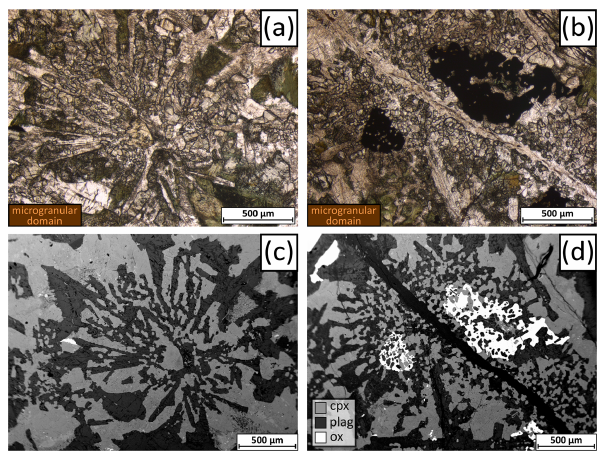
Figure 7. Rosette-like, microgranular domains within two varitex- tured gabbros ( a, c : GT3A-129Z-3, 50–57cm; b, d : GT3A-129Z-4, 8–16cm) consisting of radiating granular clinopyroxenes and lath- shaped plagioclases, sometimes associated with interstitial Fe–Ti oxides (b, d) . For details see text. (a, b) Microphotographs in plane- polarized light; (c, d) backscattered electron images.